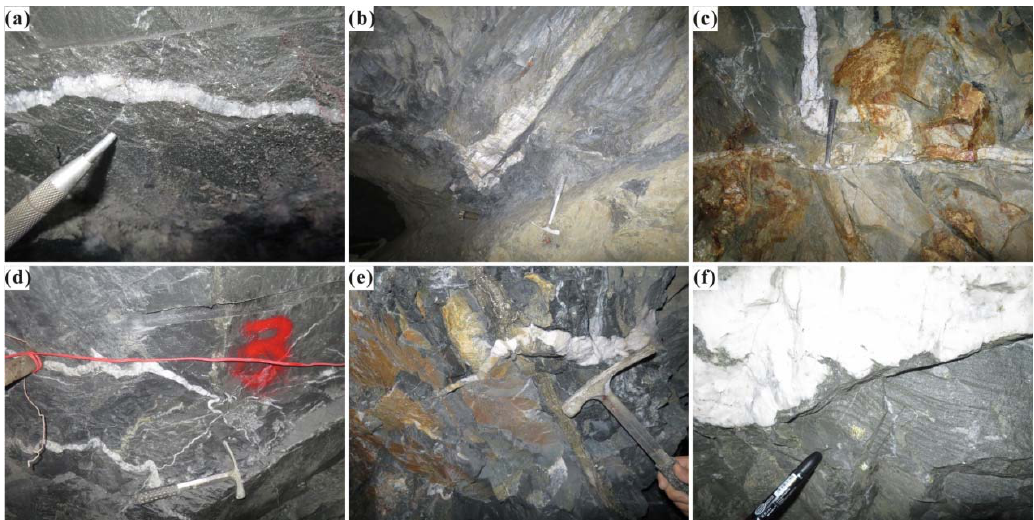
Figure 3. Photographs of various vein types in the Zhengchong Au deposit. ( a ) Disseminated pyrite and arsenopyrite in vein and country rock; ( b ) representative NE-trending laminated quartz veins. ( c ) Laminated quartz vein (NE) cuts through an earlier quartz-pyrite vein (NW) in granodiorite. ( d ) Stockwork veins and massive pyrite vein are cut by disseminated pyrite vein, and they are all cut by quartz-carbonate vein. ( e ) Massive pyrite vein and laminated quartz vein cut by barren quartz-carbonate vein. ( f ) Disseminated pyrite vein and pyrite pebble.